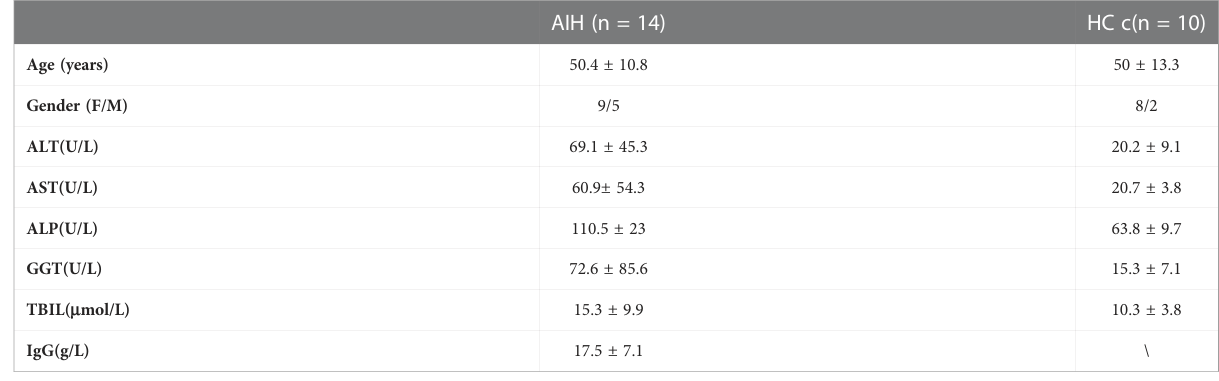
TABLE 2 Clinical Features of Patients with AIH and HC.